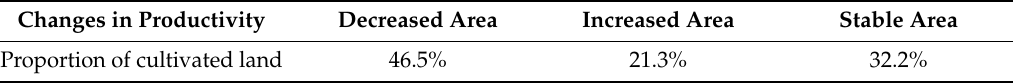
Table 1. Changes in cultivated land productivity in single cropping system.